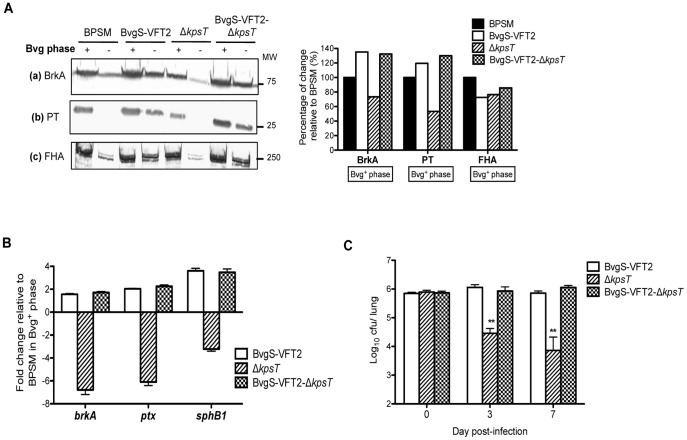
Characterization of the BvgS-VFT2-ΔkpsT mutant. (A) Production of bvg-regulated virulence proteins.BPSM, BvgS-VFT2, ΔkpsT and BvgS-VFT2-ΔkpsT strains were exponentially grown in virulent (Bvg+) and avirulent (Bvg-) phase. Western blot analysis was performed on whole cell extract (panel a) and 10x concentrated (panel b) or non-concentrated (panel c) culture supernatants using anti-BrkA (a), anti-PT (b) or anti-FHA (c) primary antibodies. Bars at the right of the blots represent protein densitometry quantification expressed as percentage of change relative to parental BPSM in Bvg+ phase. Results are representative of three independent experiments. Molecular weights are indicated on the right side. (B) Relative transcriptional activity of
vags
. Total RNA was extracted from BPSM, BvgS-VFT2, ΔkpsT and BvgS-VFT2-ΔkpsT strains grown in virulent Bvg+ phase. Real-time PCR analysis was performed using primers mapping in the brkA, ptx, and sphB1 genes. recA gene was used as the endogenous control. Results are expressed for each target gene as average fold change ± SD of triplicate Ct values obtained with BvgS-VFT2, ΔkpsT and BvgS-VFT2-ΔkpsT versus the Ct value obtained with BPSM strain. The results are representative of two independent experiments. (C) Lung colonization profile. Balb/C mice were infected intranasally with 5×105 CFU of B. pertussis BvgS-VFT2, ΔkpsT and BvgS-VFT2-ΔkpsT. At the indicated time points, four infected mice per group were euthanized and their lungs were harvested, homogenized and plated on blood agar to determine the total number of CFU per lung. The results are expressed as the mean ± SEM of four mice per group. ** p value<0.01 relative to BPSM. Results are representative of two independent experiments.